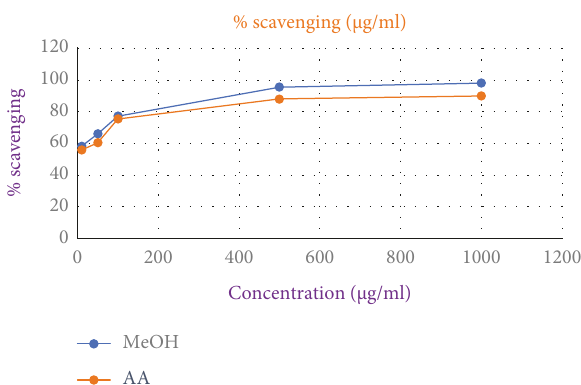
Figure 3: Free radical scavenging activity of methanolic extract from S . gigas stem bark and standard (ascorbic acid).